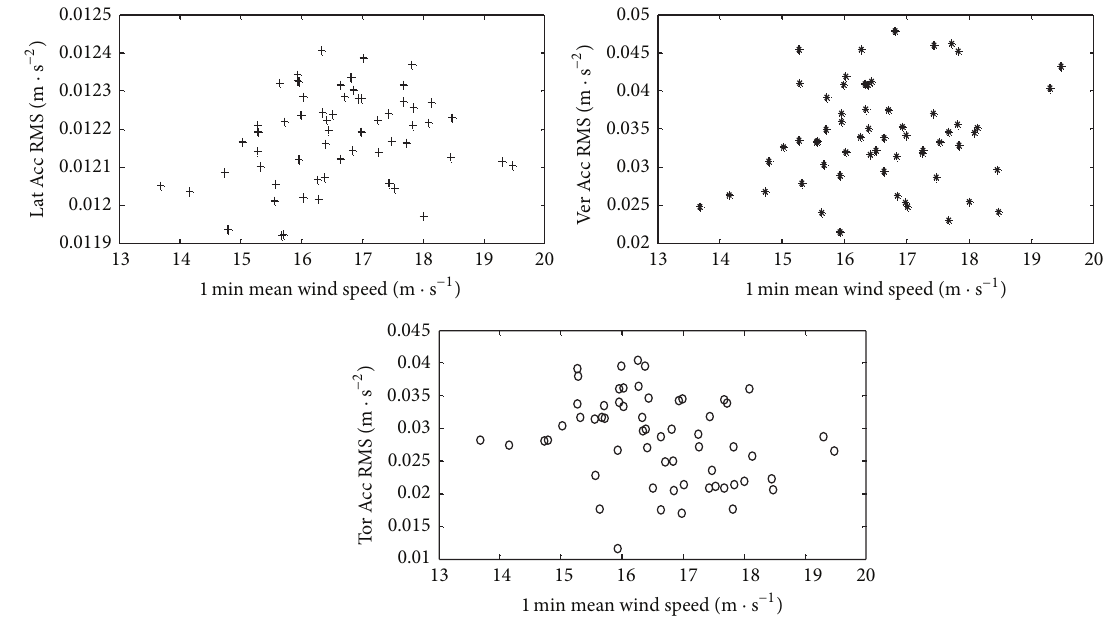
Figure 16: Variation of deck acceleration response RMS at ACC2-5 versus mean wind speed.